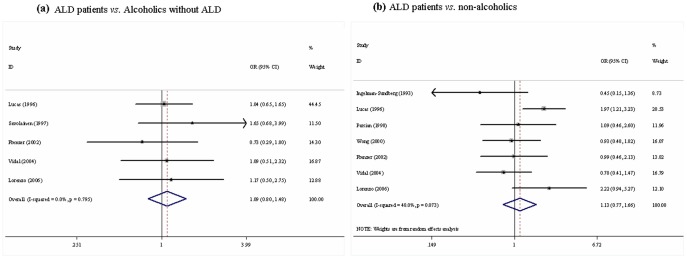
Meta-analysis for CYP2E1 Dra I polymorphism and the risk of ALD in Caucasians (d1 vs. d2).(a) ALD patients vs. alcoholics without ALD; (b) ALD patients vs. non-alcoholics. Each study was shown by a point estimate of the effect size (OR) (size inversely proportional to its variance) and its 95% confidence interval (95%CI) (horizontal lines). The white diamond denotes the pooled OR.